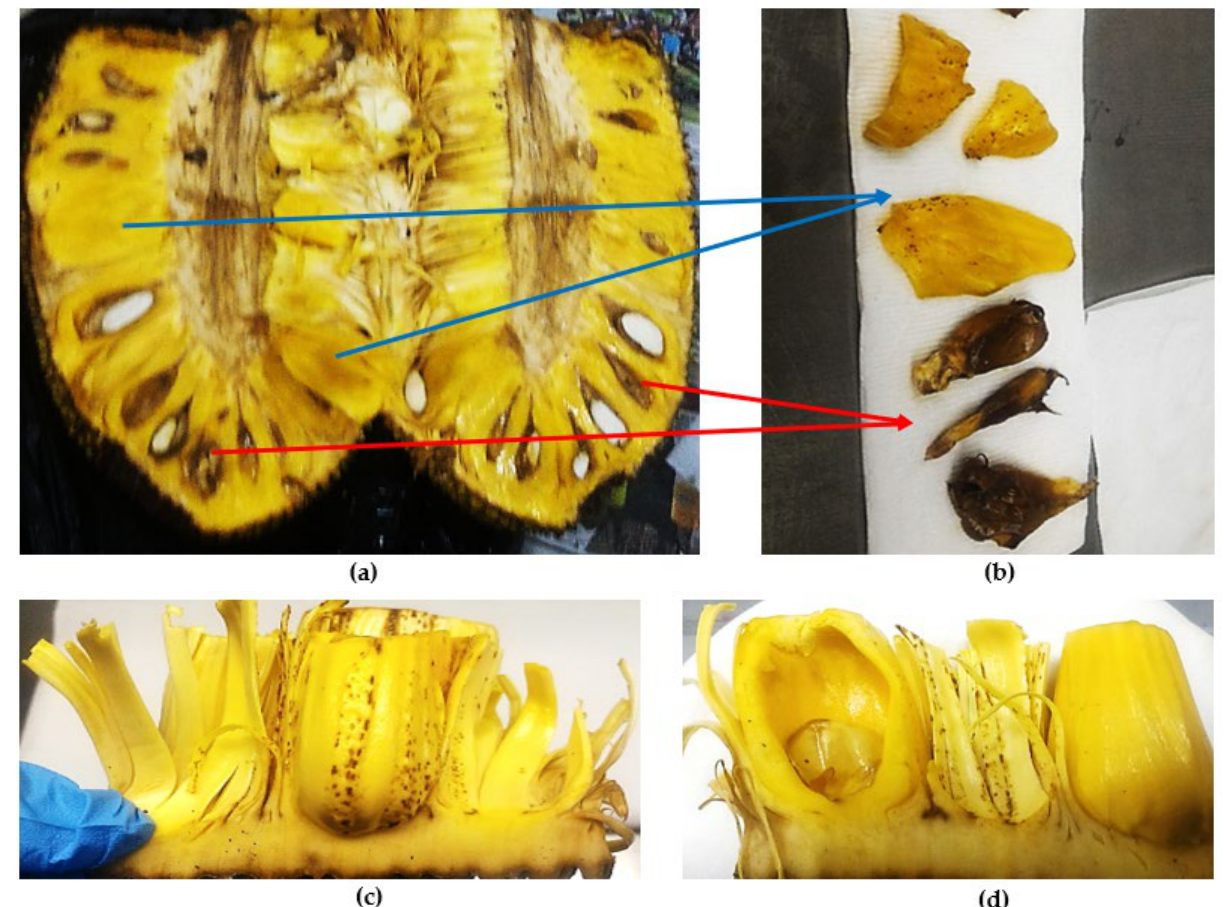
Figure 3. Symptoms of jackfruit-bronzing are present on the internal fruit parts. ( a ) Yellowish orange to reddish discoloration of the affected pulps and rags. ( b ) The pulps (blue arrows) and rags (red arrows) on clean tissues before isolation. The apparent brown specks symptoms on the infected ( c ) pulps and ( d ) rags (Figures were from personal collection).